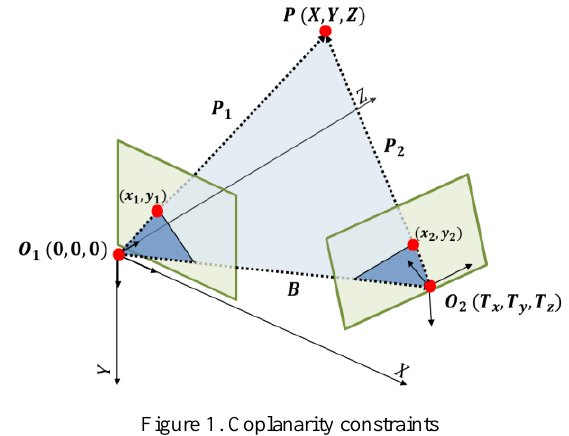
Figure 1. Coplanarity constraints